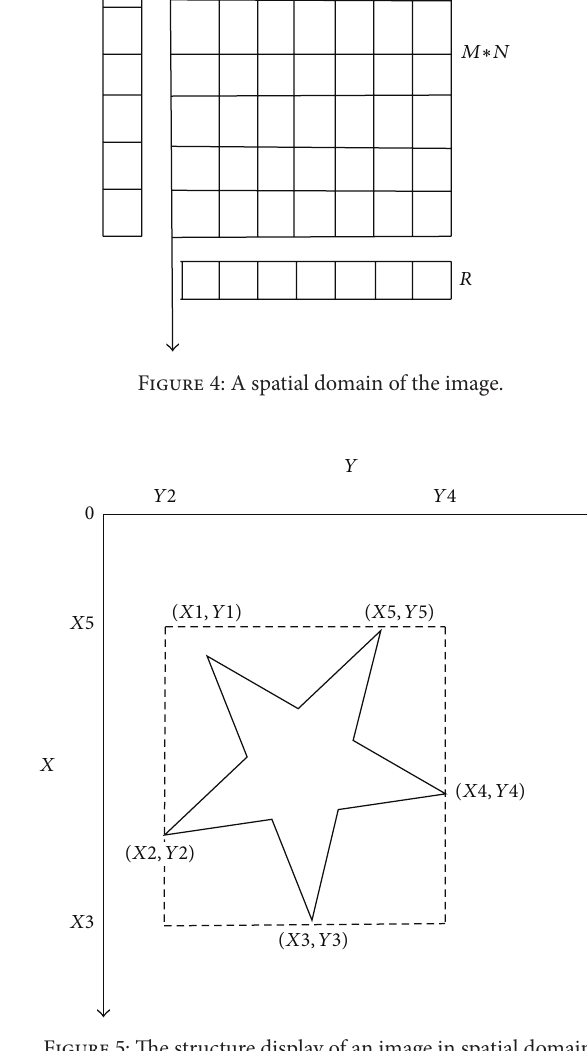
Figure 5: The structure display of an image in spatial